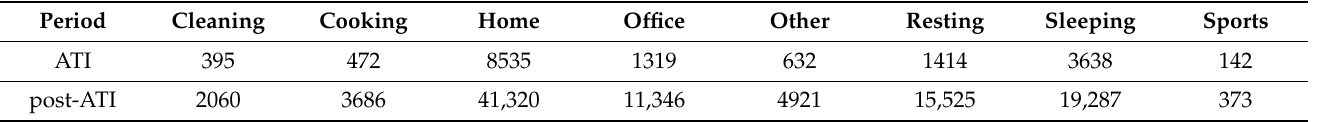
Table 2. Number of instances for each indoor activity during the ATI period and in the post-ATI period.